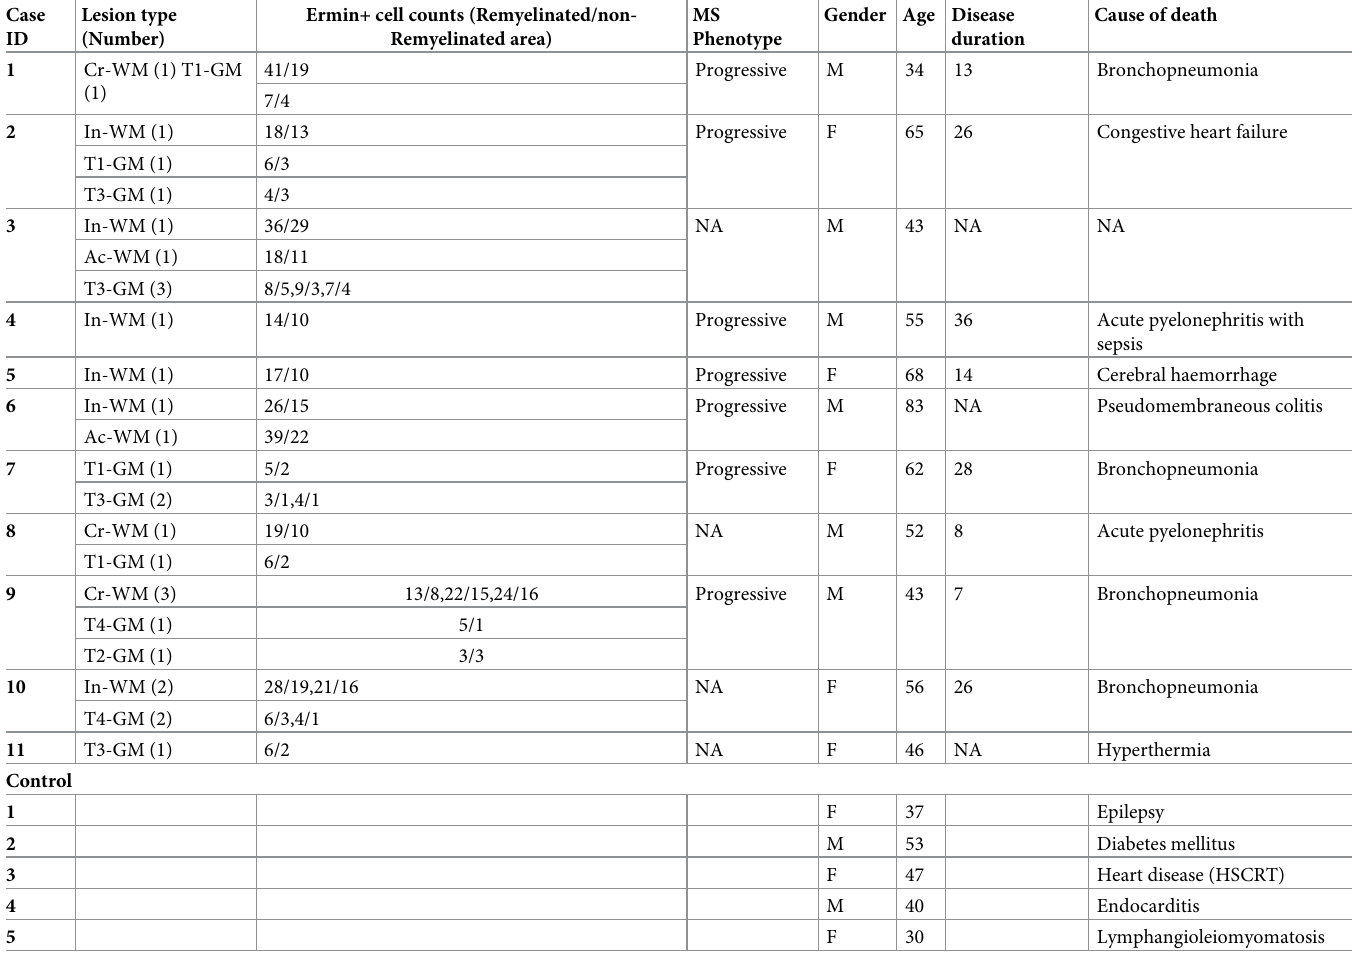
Table 1. Clinical and demographic description of MS brain autopsies and control